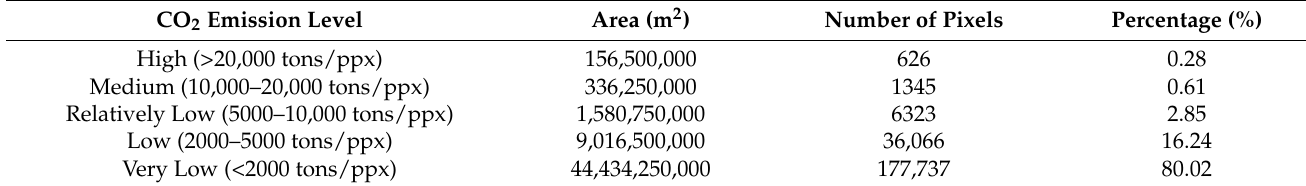
Table 3. Proportion of regions with different CO 2